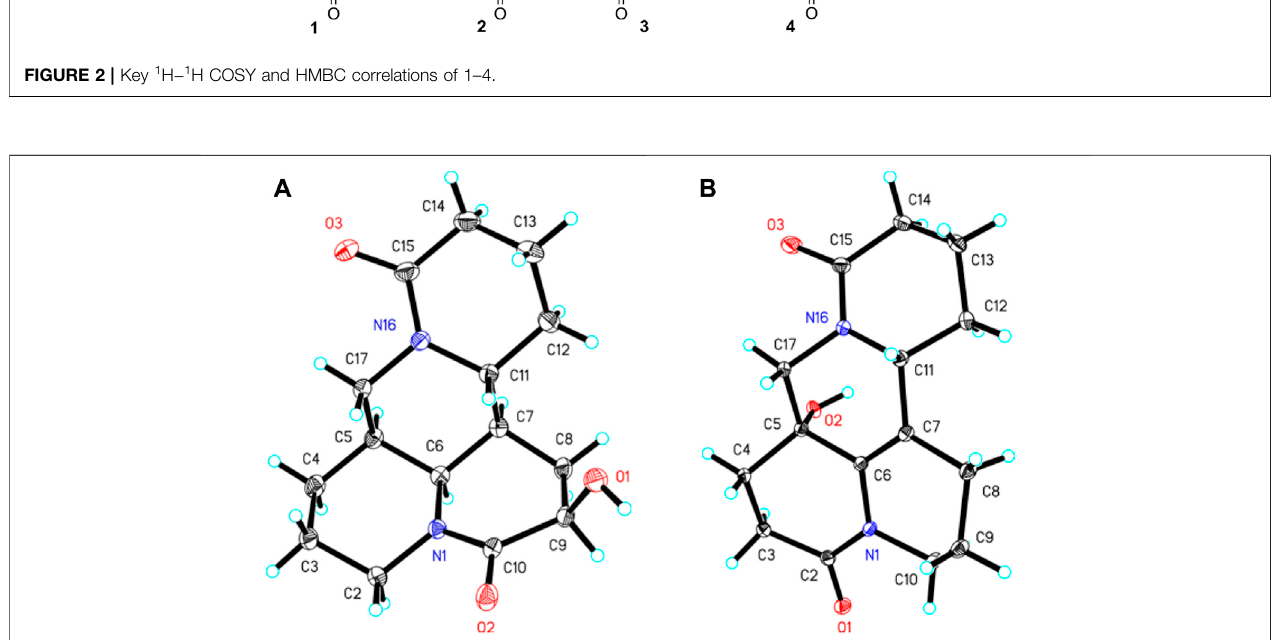
FIGURE 3 | X-ray ORTEP drawings of 1 (A) and 3 (B)